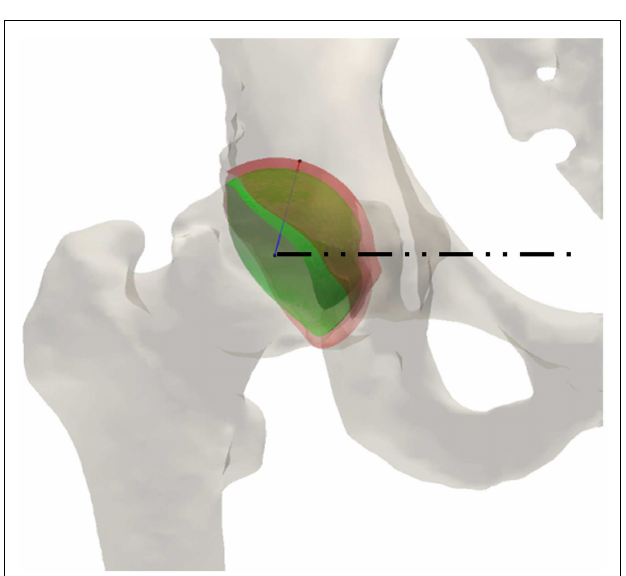
FIGURE 4 | Ray-firing method for indirect computation of cartilage thickness from CT data using bony surfaces .The green and red surface models represent the contact surface on femoral and acetabular sides, respectively.The blue line shows the radial direction from the center of the femoral head to an arbitrary point on the femoral head surface.The red line delineates the radial distance between the femoral head and acetabulum contact surfaces.The dashed line is the medio-lateral axis of the hip, extending through the centers of the femoral